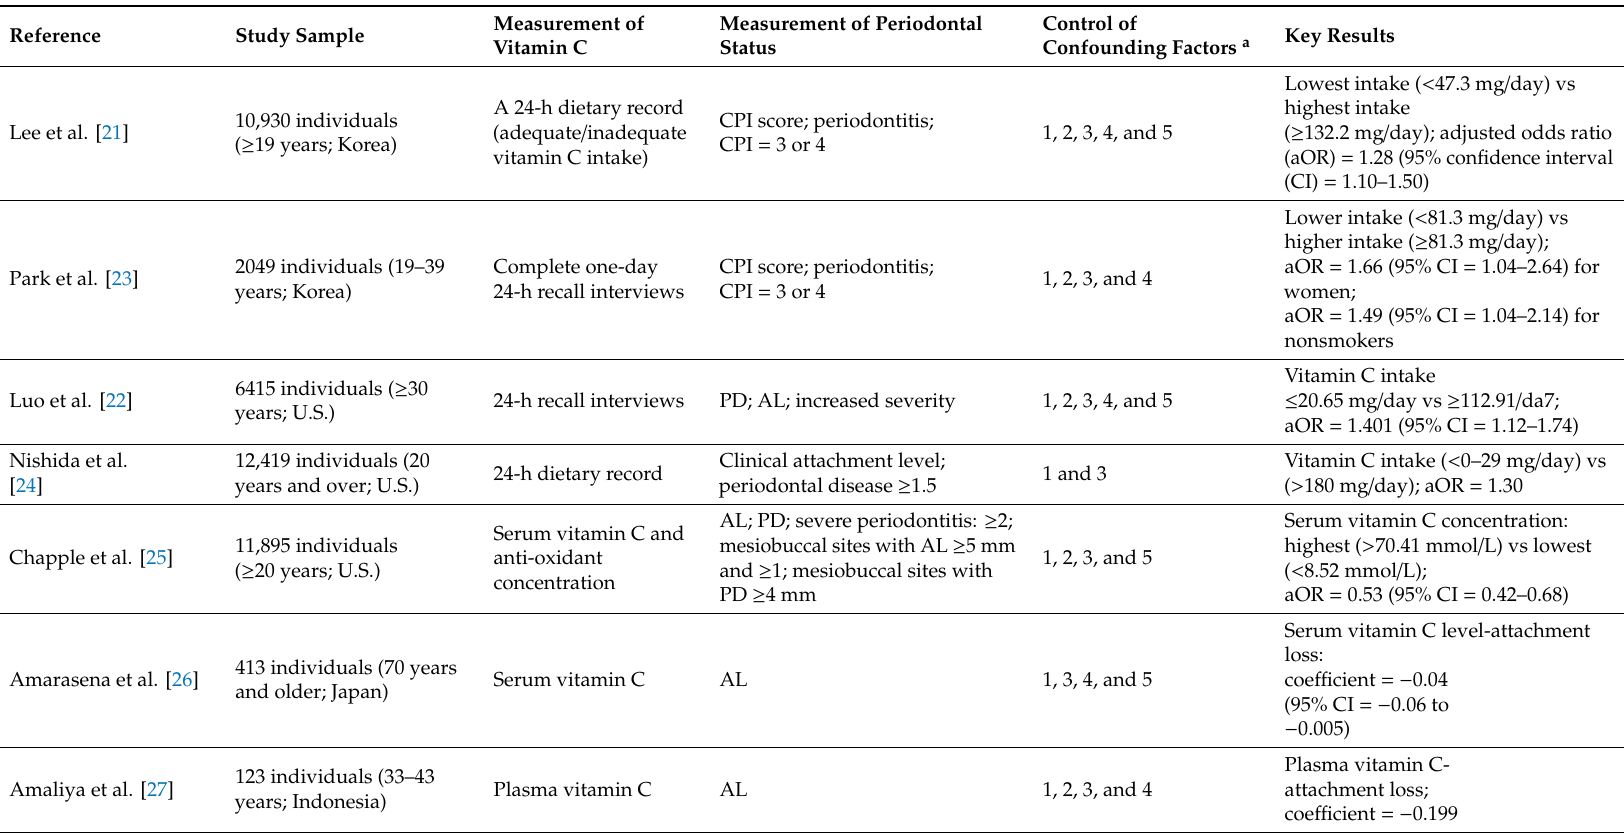
Table 6. Summary of cross-sectional studies on the relationship between vitamin C and periodontal